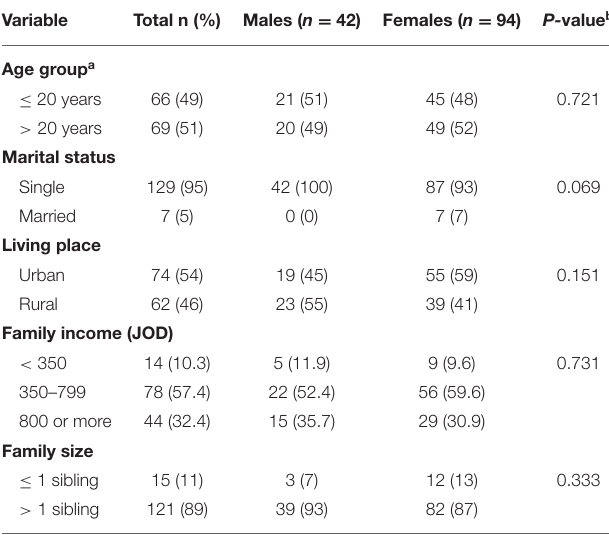
TABLE 1 | The sociodemographic characteristics of the study population stratified by gender ( n = 136).